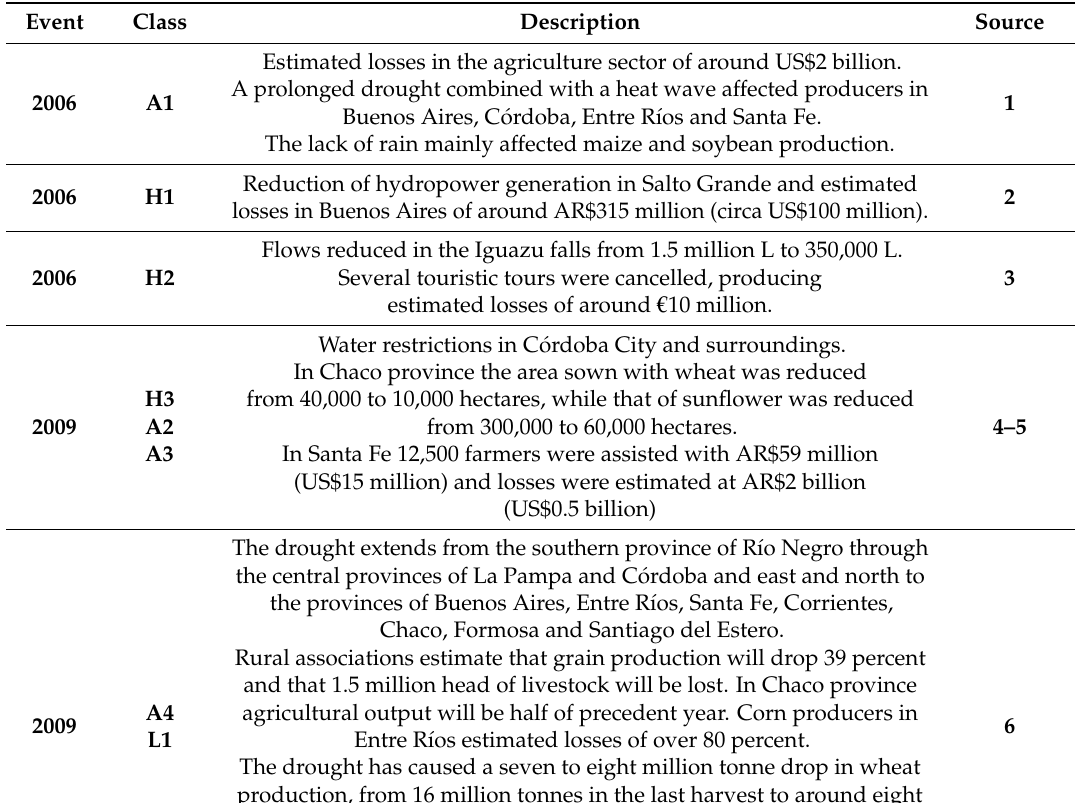
Table A1. Summary of the selected media reports reviewed in this study. Impacts were classified in three main categories: Agricultural (A), Hydrological (H) and Livestock